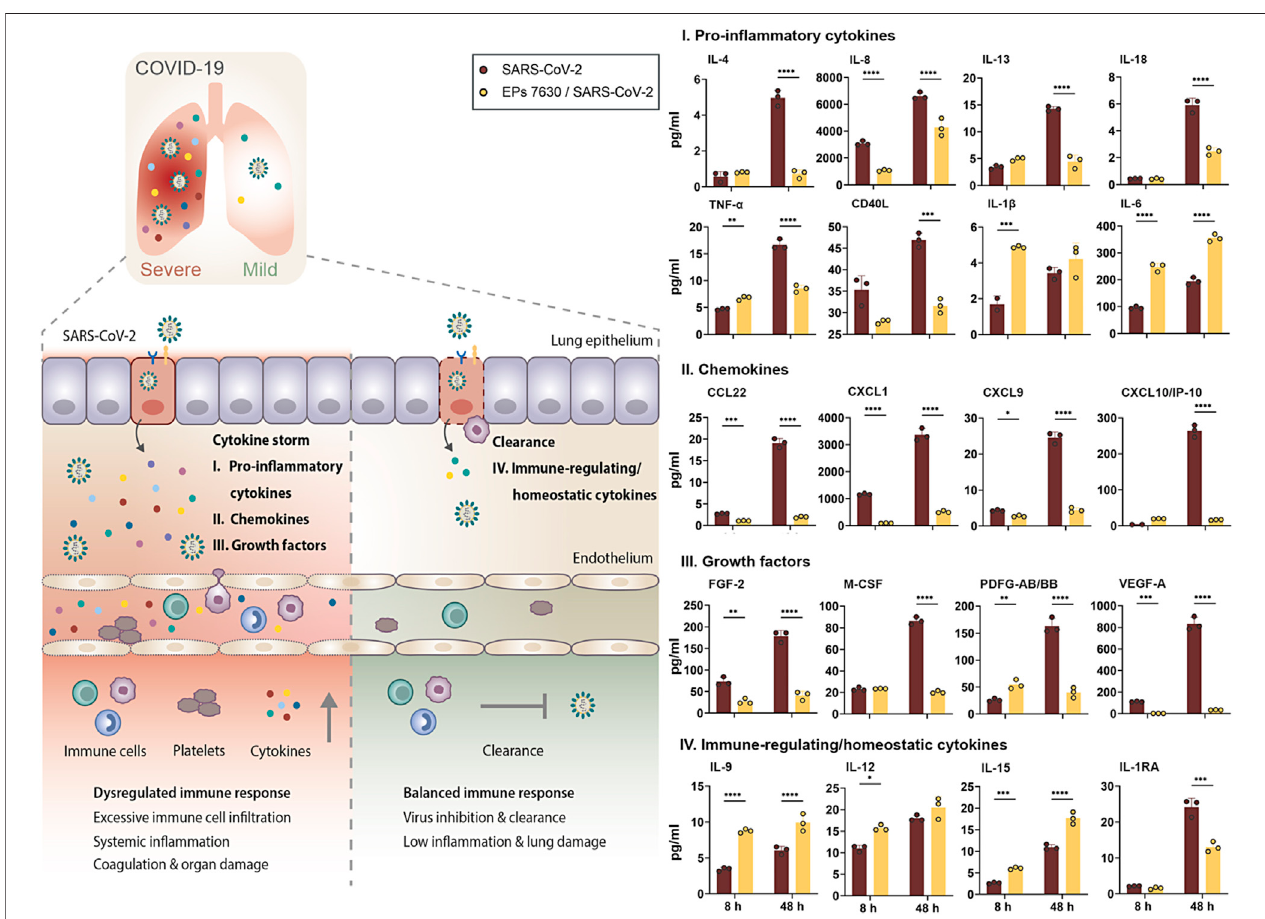
FIGURE 6 | EPs 7630 treatment limits SARS-CoV-2-induced in fl ammation in Calu-3 lung cells. Supernatants from EPs 7630-treated (100 μ g/ml) and EPs 7630-treated and SARS-CoV-2 infected (MOI (cid:2) 0.0005) Calu-3 cells were analyzed at 8 and 48 h post-infection using the Human Cytokine/Chemokine/Growth Factor Multiplex Assay (Merck Millipore) with the Luminex MAGPIX System according to the manufacturer ’ s instructions. Data are derived from n (cid:2) 3 biological samples (for IL-1 β , CXCL10/IP10: n (cid:2) 2 – 3). Vehicle (cid:2) medium only. Statistical signi fi cance is indicated by (*) as determined by two-way ANOVA with Tukey ’ s multiple comparison test. Asterisks are shown only for signi fi cantly different data sets. (*) (cid:2) p < 0.05; (**) (cid:2) p < 0.01; (***) (cid:2) p < 0.001; (****) (cid:2) p < 0.0001.